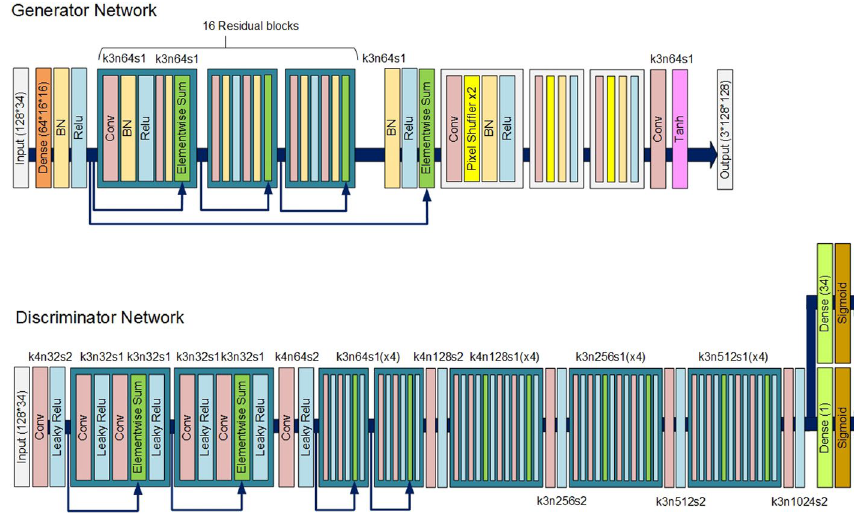
Fig. 17 The architecture of Anime G &